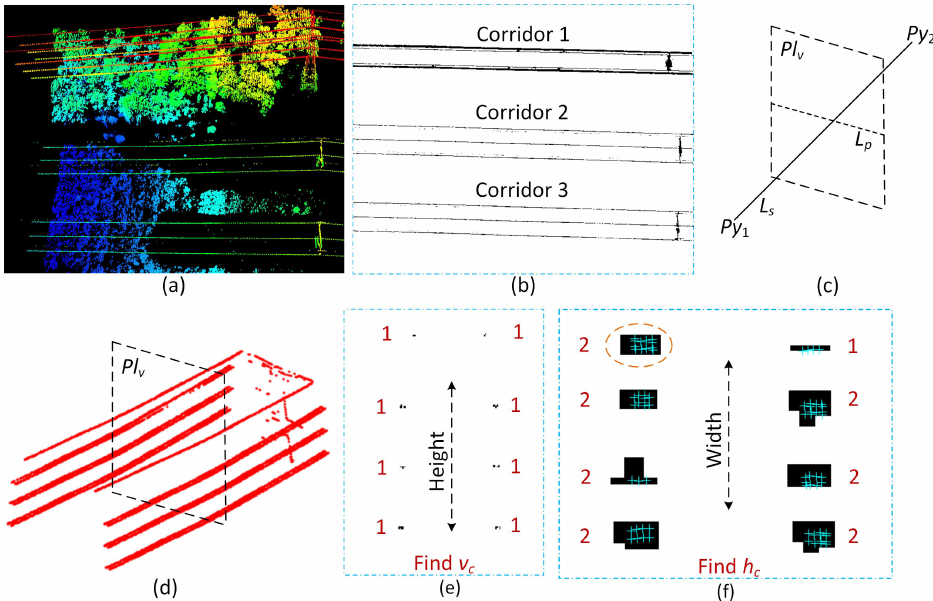
Figure 12. Counting the number of wires: ( a ) sample scene; ( b ) PL mask M p ; ( c ) corridor axis L s and vertical plane Pl v ; ( d ) input points between an end and a pylon of Corridor 1; ( e ) clusters of wires in vertical mask M v ; and ( f ) connected components from PL mask M p ( L p = perpendicular line to L s , v c = vertical count of wires and h c = horizontal count of